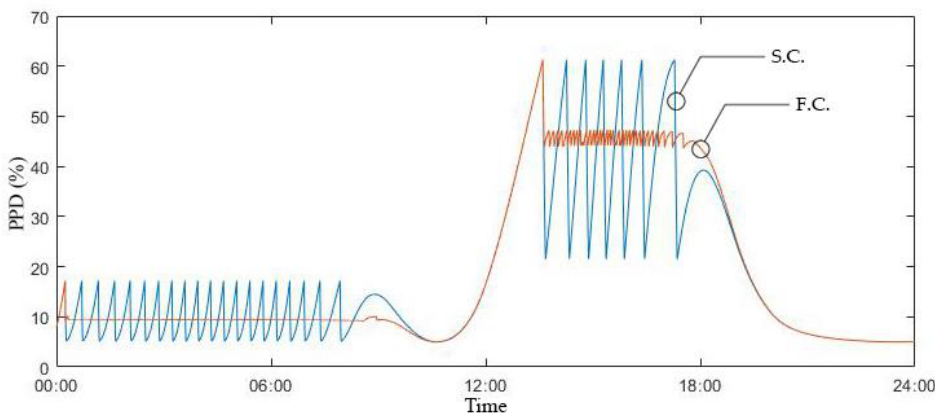
Figure 6. Comparison of T room between S.C. and network-based controller (NC).